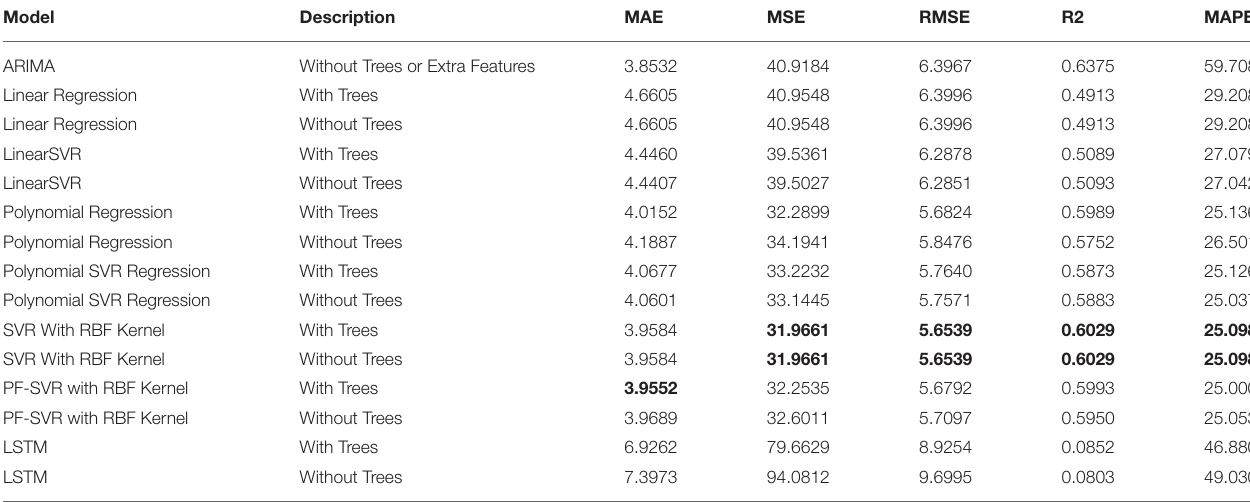
TABLE 8 | Experimental results for PM10, location-1, and Parker Street.